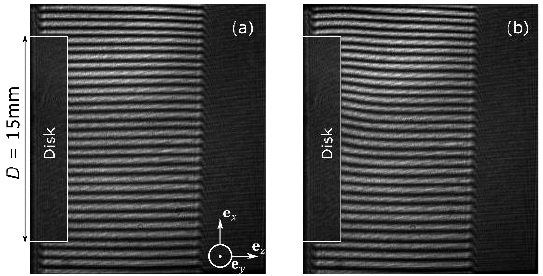
Fig. 2. Snapshots of the interference patterns obtained with the MZI (a) at room temperature and (b) with the pumped disk.